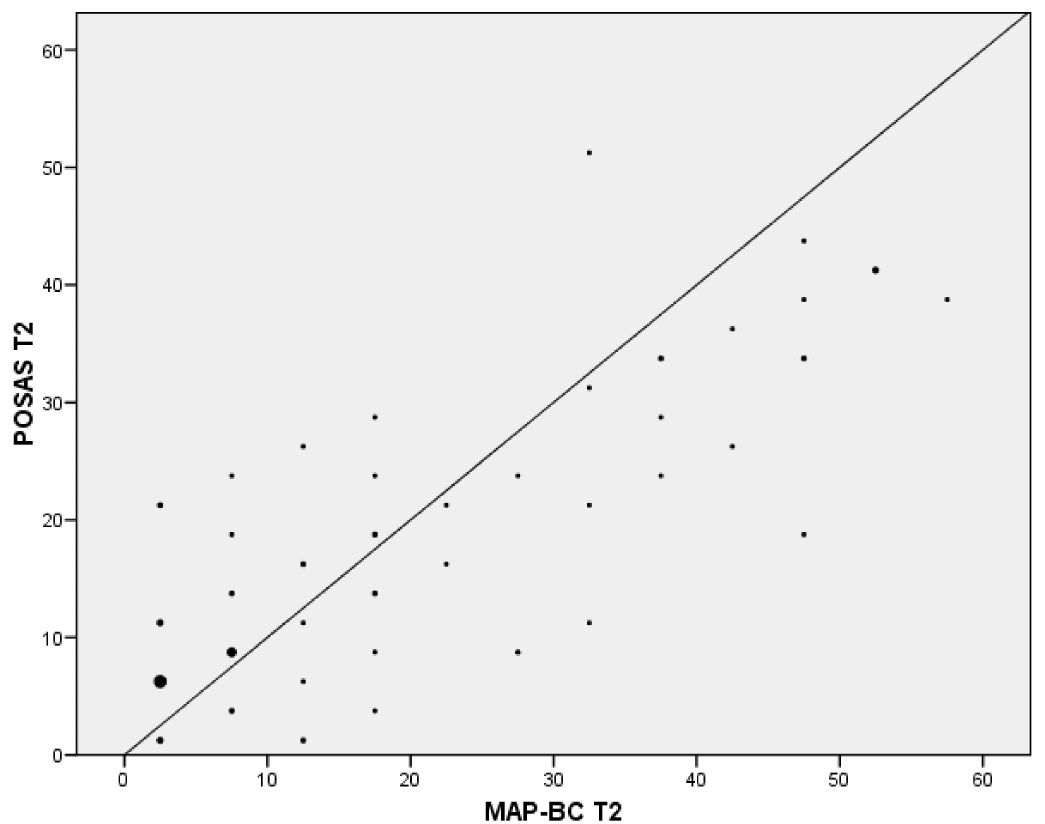
Figure 2. Correlation at T2 between the Myofascial Adhesions for Patients after Breast Cancer (MAP-BC) Spanish version with the Patient and Observer Scar Assessment